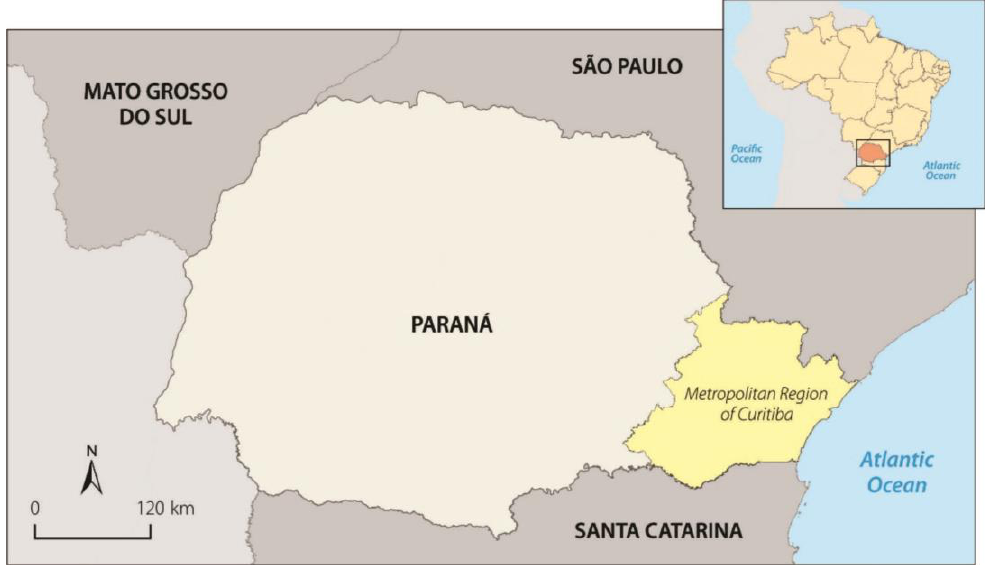
Figure 3. The Metropolitan Mesoregion of Curitiba within the Brazil and Paraná State